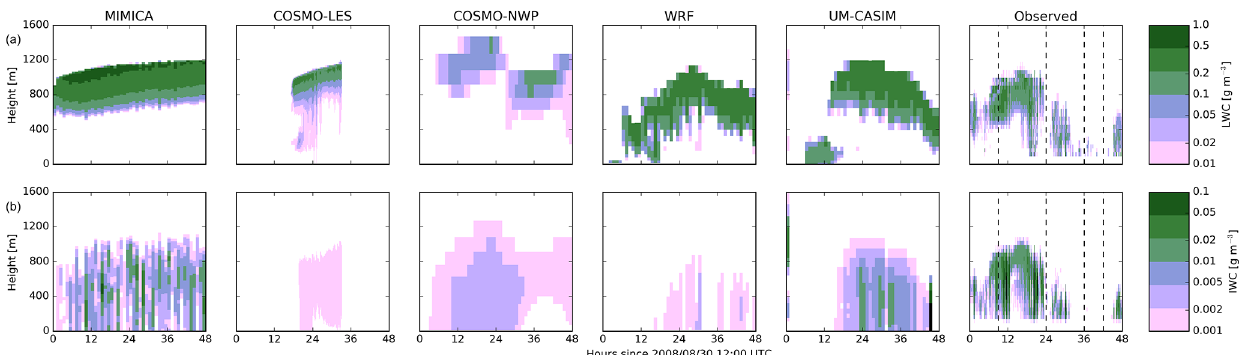
Figure 11. Liquid and ice water content in the simulations with a prescribed CDNC of 30cm − 3 and a prescribed ICNC of 0.2L − 1 (CDNC30_ICNC0p20), and liquid and ice water content derived from observations. (a) Liquid water contents, (b) ice water contents. Results are shown (left to right) from the MIMICA, COSMO-LES, COSMO-NWP, WRF, and UM-CASIM models. Values derived from observations are shown in the rightmost column. Vertical dashed lines indicate the beginnings and endings of the cloudy and nearly cloud-free periods.